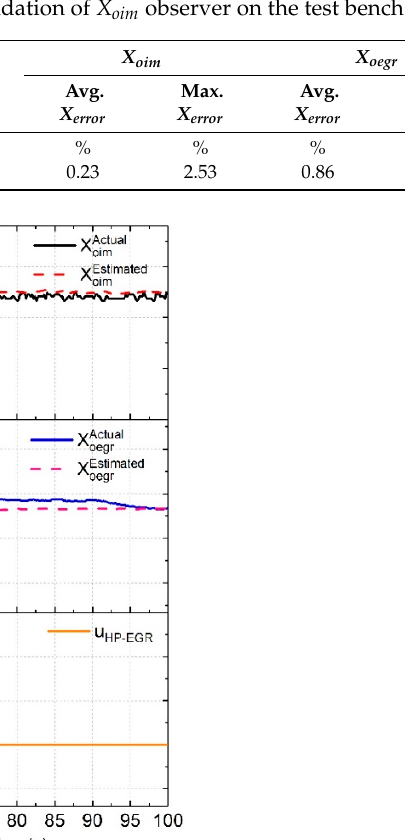
Table A1. Case setup and results for the validation of X oim observer on the test bench.